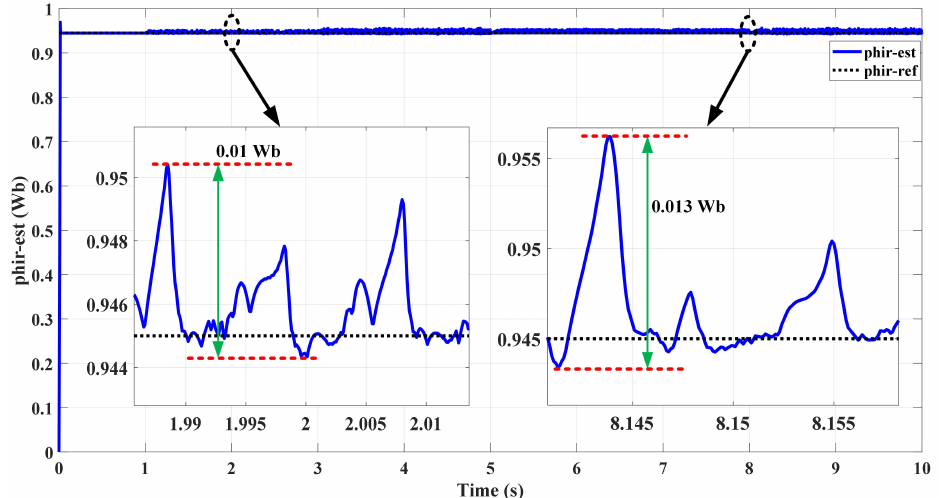
Figure 10. Rotor flux response for the conventional and the improved